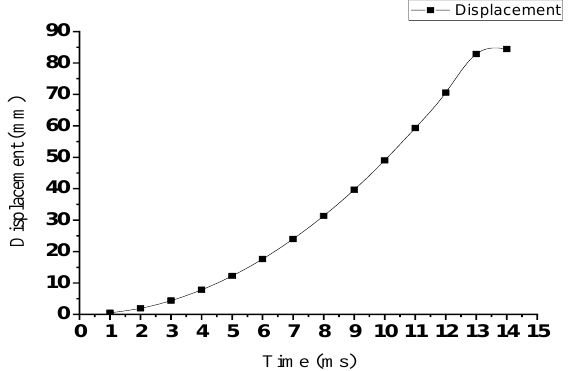
Figure 12. Displacement of the ferry from a side explosion of 5 kg